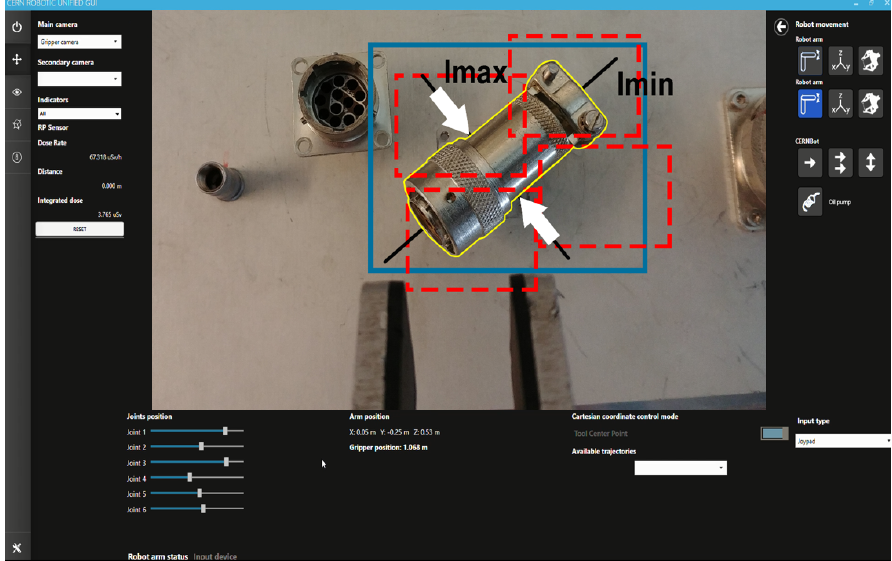
Figure 21. Grasping Determination calculation on a metallic connector, to be grasped and inserted (specular symmetry).